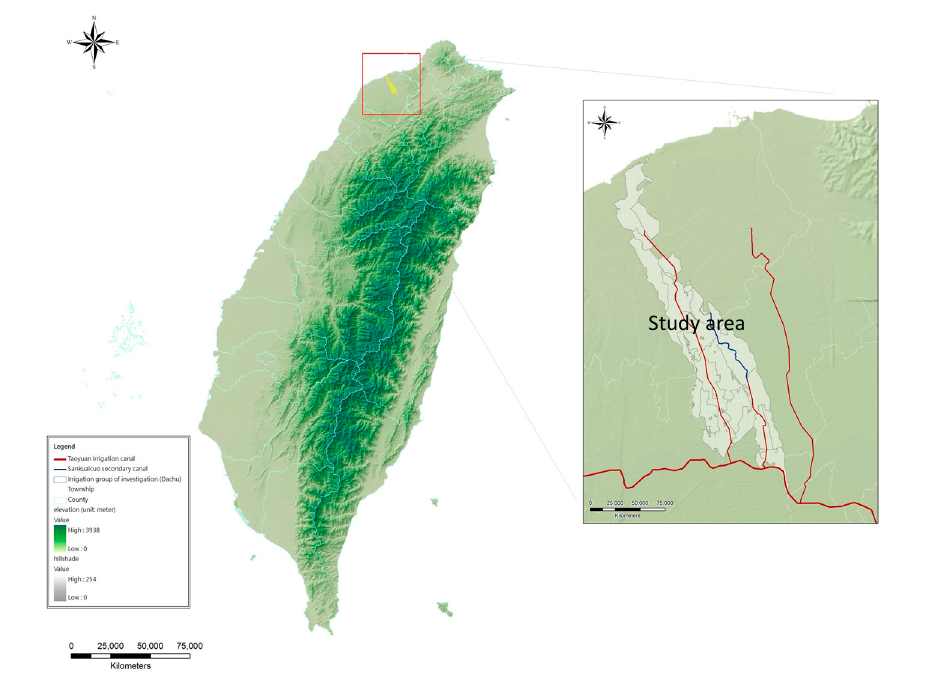
Figure 2. The distribution of the pilot study area.